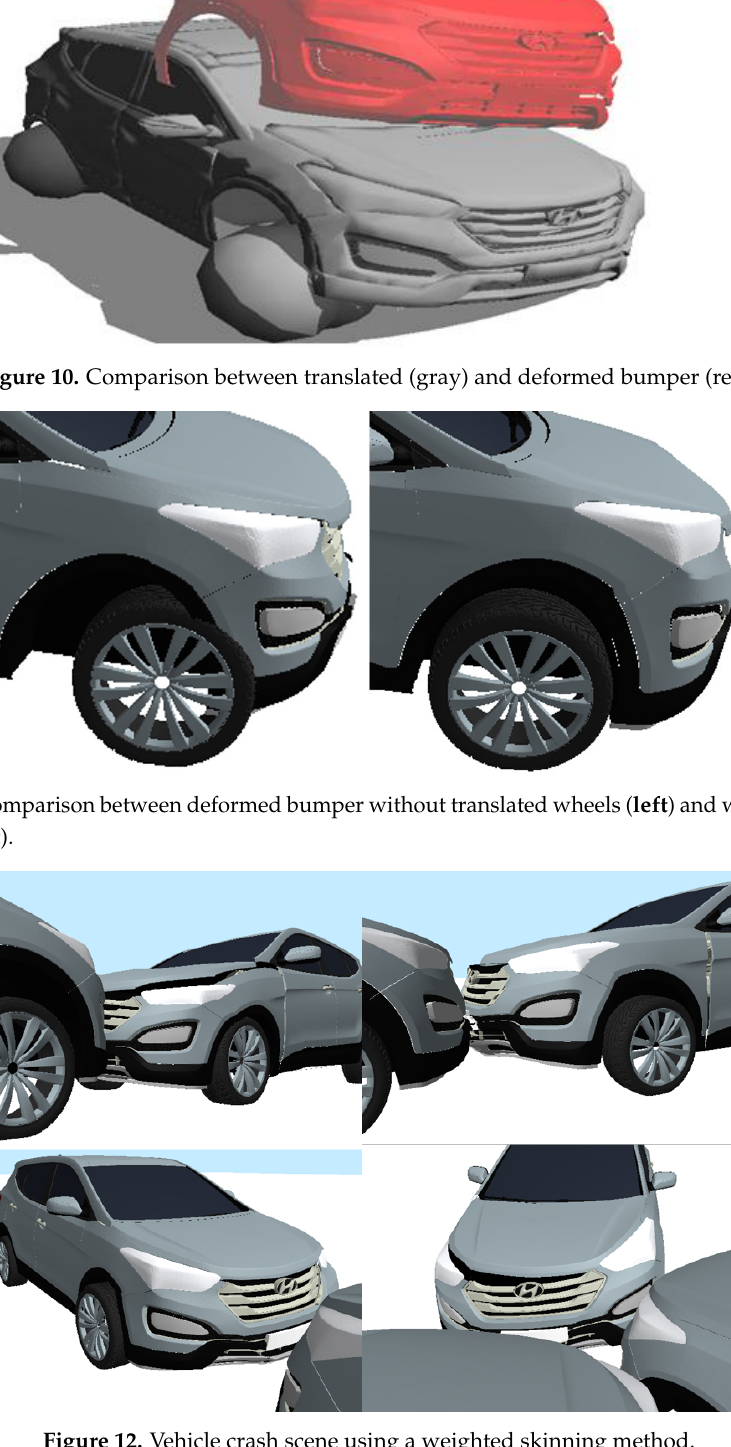
Figure 12. Vehicle crash scene using a weighted skinning